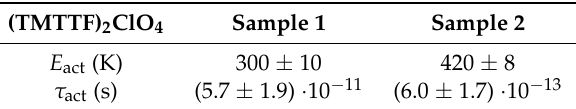
Table 3. Parameters of the activated behavior of τ 0 for (TMTTF) 2 ClO 4 derived from dielectric measurements of two different